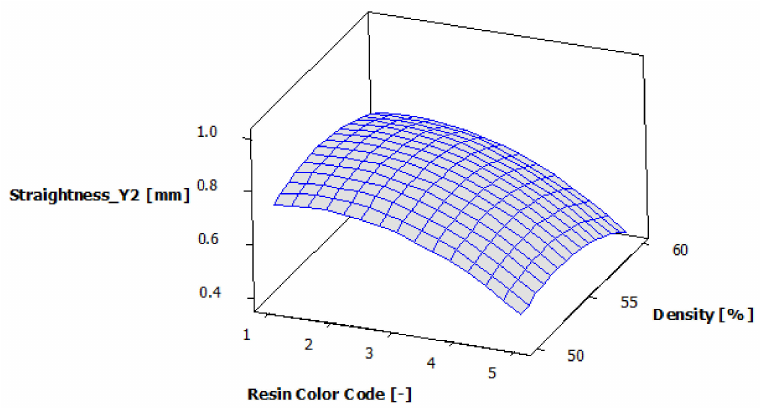
Figure 22. Estimated response surface for Straightness_Y2.